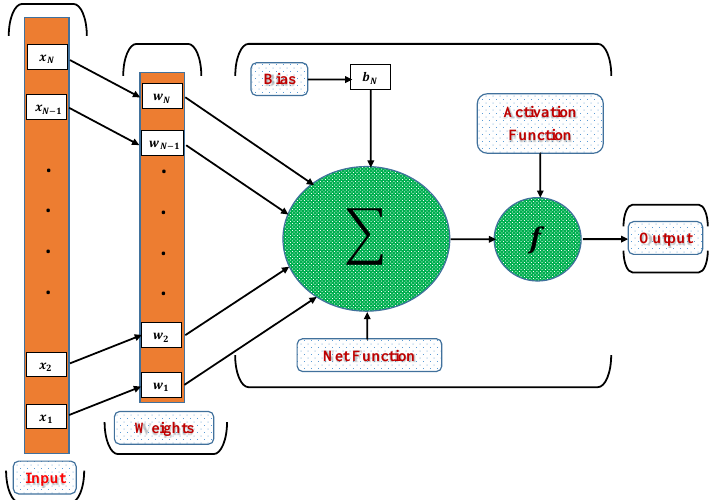
Figure 4. Details of a neuron in an MLP